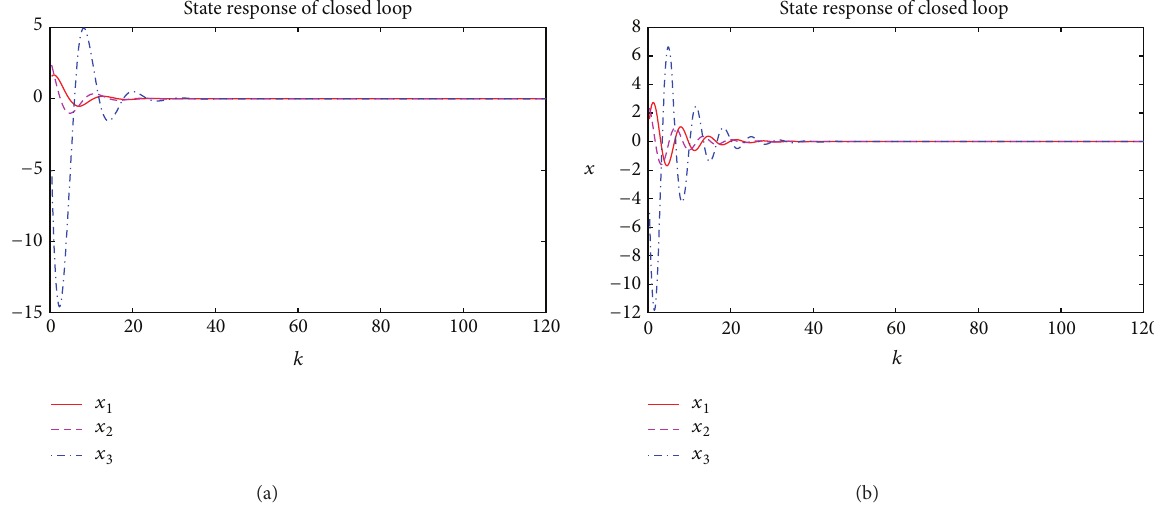
Figure 2: Comparison of the closed-loop state responses ((a) using our method and (b) using the method proposed in [4]).